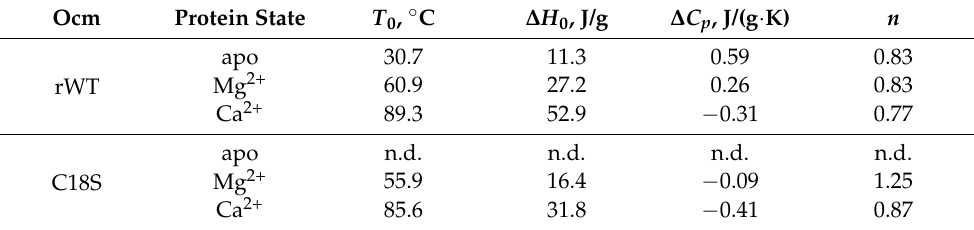
Table 3. Thermodynamic parameters of thermal denaturation of various states of rWT/C18S Ocm, estimated from the DSC data shown in Figure 3 according to the cooperative two-state model [III]: mid-transition temperature ( T 0 ), enthalpy of protein denaturation at temperature T 0 ( ∆ H 0 ), heat capacity change accompanying the transition ( ∆ C p ), and number of molecules involved in the transition ( n ). Ocm Protein State T 0 , ◦